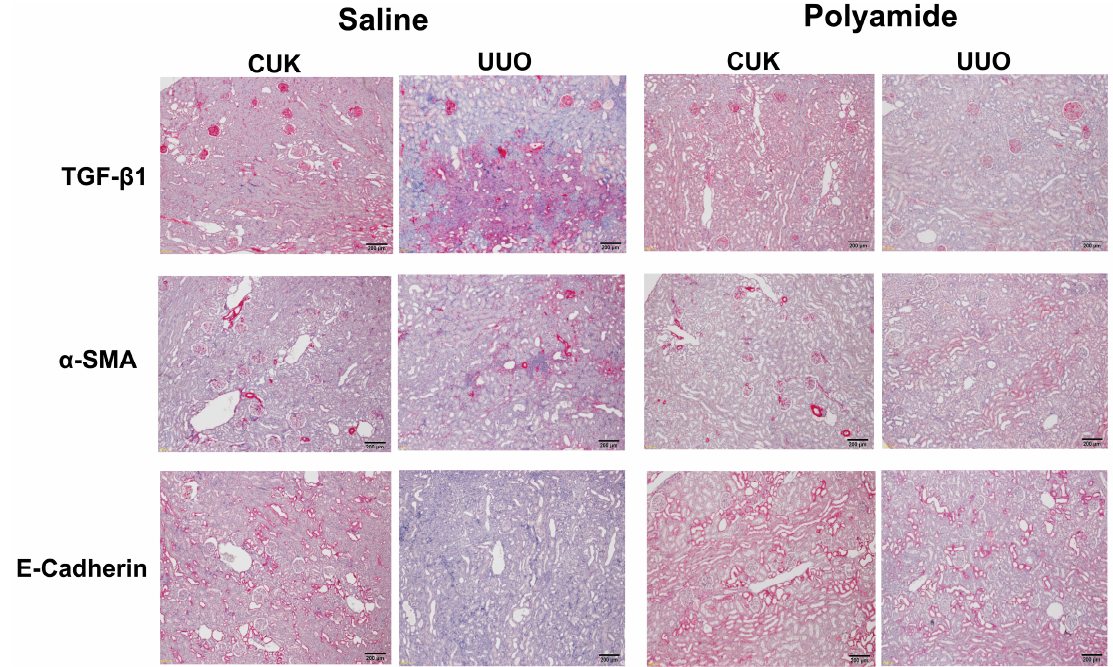
Figure 6. The e ff ects of pyrrole-imidazole polyamide targeting human TGF- β 1 (Polyamide) on the expression of TGF- β 1, α -SMA, and E-cadherin in the kidney with unilateral urethral obstruction (UUO) in marmosets with UUO. The left ureter was ligated, whereas, in the sham-operated marmosets, the left ureter was not disturbed. Marmosets with UUO were intravenously injected with Polyamide (1 mg / kg / week) through the tail vein for four weeks from one week after the operation. CUK, contralateral unobstructed kidney. Control marmosets with UUO were intravenously injected with the same amount of saline through the tail vein.